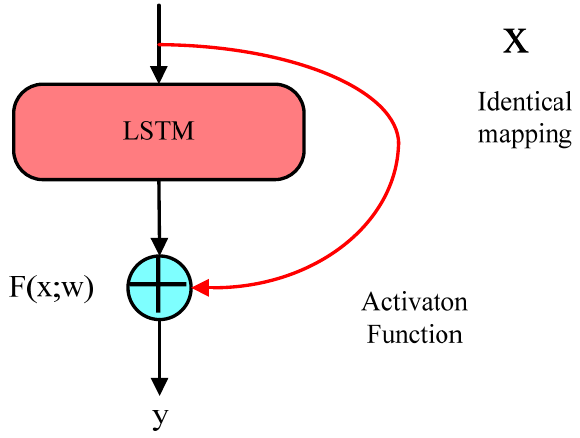
Figure 3. Long short-term memory structure.